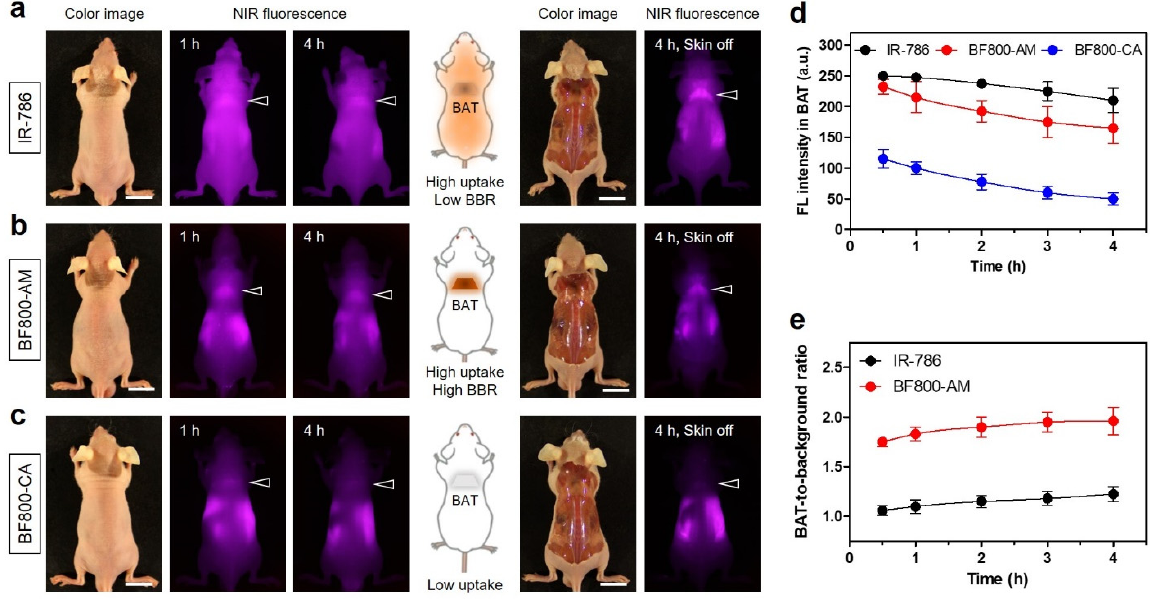
Figure 5. In vivo BAT-targeting efficiency of IR-786, BF800-AM, and BF800-CA NIR dyes. NIR fluorescence imaging 1 and 4 h after injection of ( a ) IR-786, ( b ) BF800-AM, and ( c ) BF800-CA NIR dyes. ( d ) Time-dependent fluorescence intensities at the BAT sites targeted by IR-786, BF800-AM, and BF800-CA NIR dyes. ( e ) Time course of BAT-to-background ratio (BBR) for 4 h post-injection of IR-786 and BF800-AM. BBR was calculated as the fluorescence intensity of BAT versus the fluorescence intensity of neighboring tissue obtained at different time points. The BAT sites are indicated by arrowheads. Scale bars = 1 cm. Images are representative of three independent experiments. All NIR fluorescence images have identical exposure times and normalization.